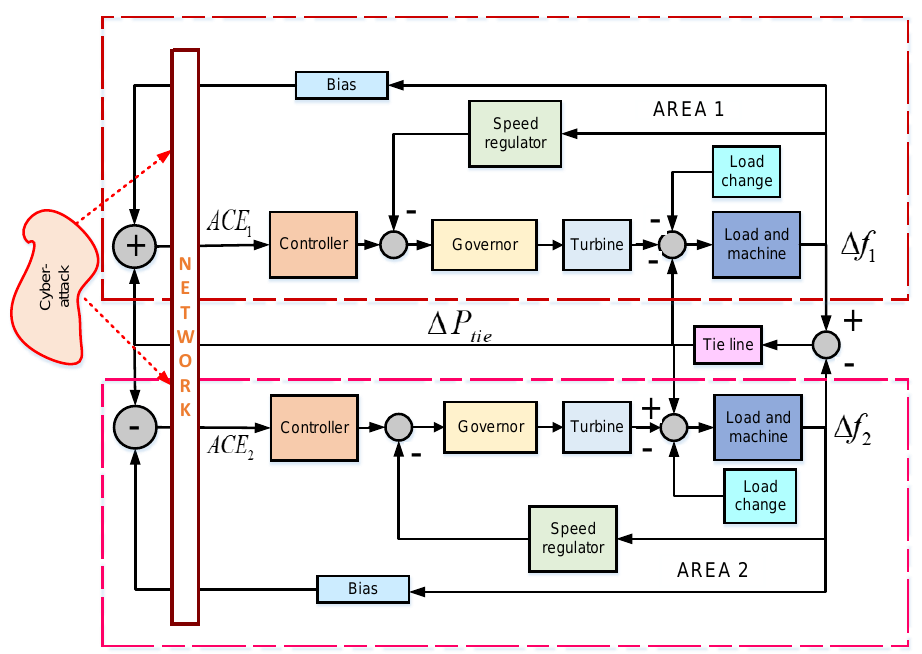
Figure 1. A typical two-area power system with LFC loops. All the paths for signal transmission passing through a rectangle “NETWORK” are the possible points from where the attacker can gain access to the